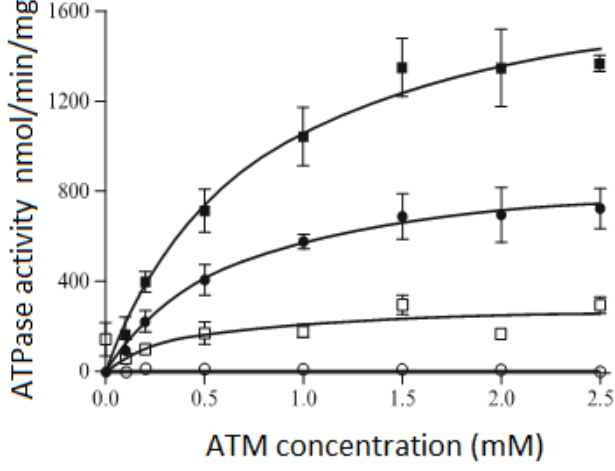
Figure 6. Comparsions of the ATPase activity of P-glycoprotein in nanodiscs (square) and proteoliposomes (circle). Open symbols: basal activity in the absence of drug; filled-in symbols: activity in the presence of nicardipine